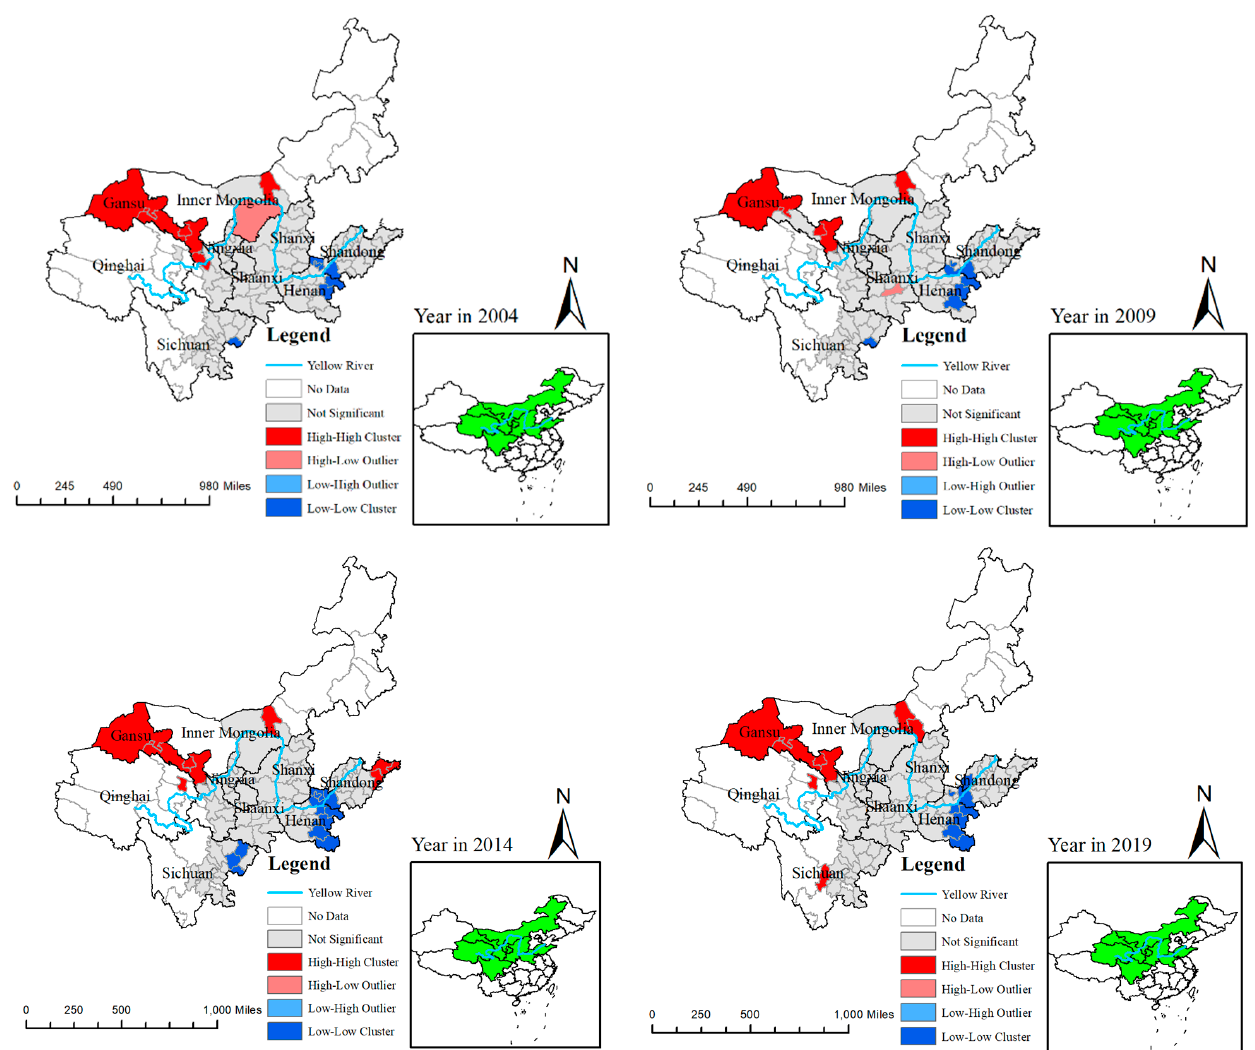
Figure 8. Spatial agglomeration characteristics of ECP in the YRB in different year.